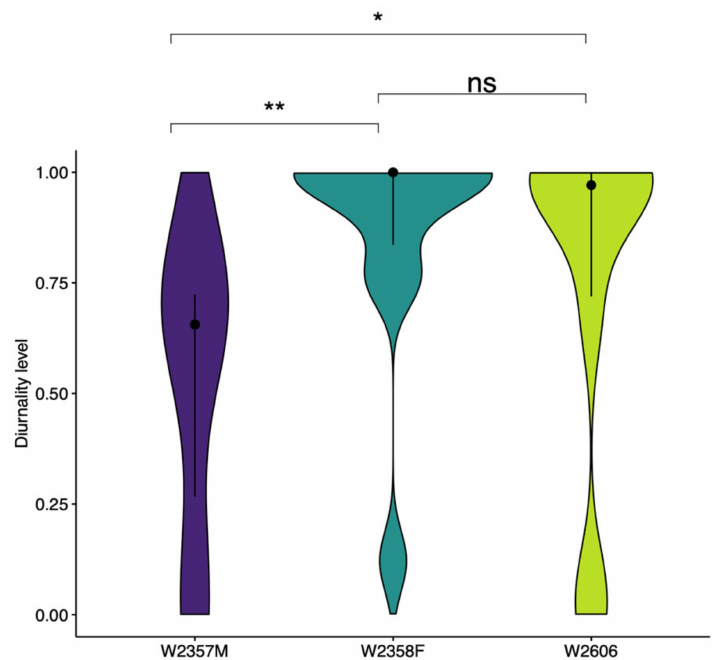
Figure 6. Violin plots with the distribution of resting sites based on their level of diurnality (from 0, fully nocturnal, to 1, fully diurnal), for each wolf. The median (Q2, black dot) and the interquartile range (Q1–Q3, solid line) are shown for reference. Pairwise Wilcoxon test comparisons between individuals, with associated significance levels, are reported above each plot. ns. not significant; * p < 0.05; ** p <